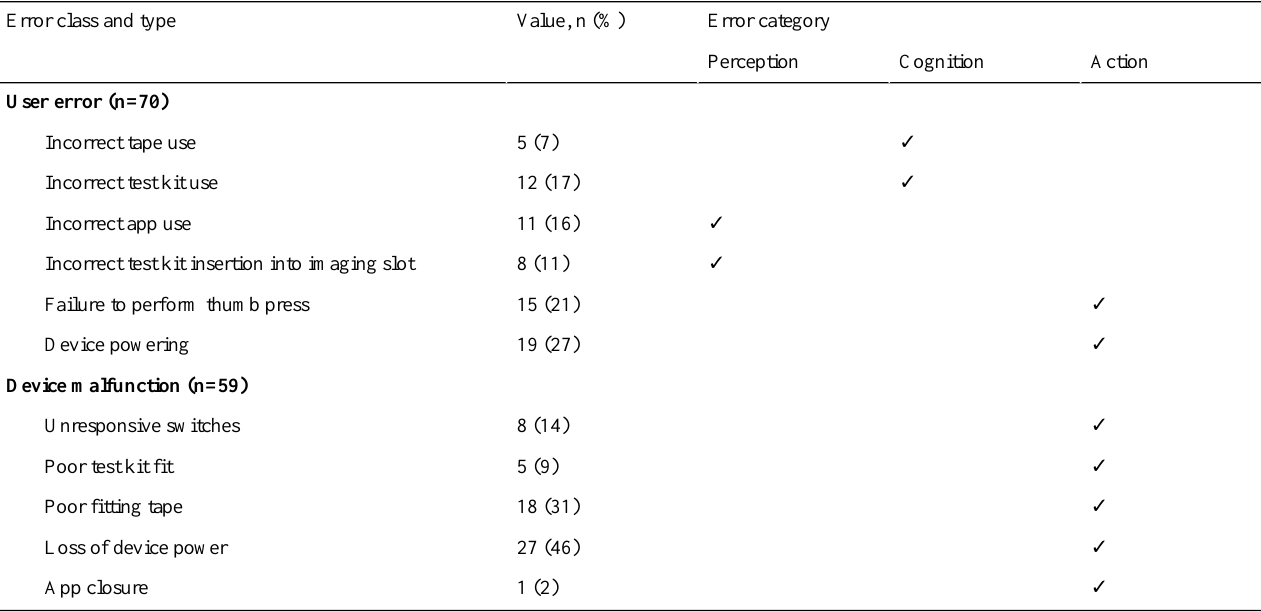
Table 3. Descriptive frequencies of aggregate user errors and device malfunctions.